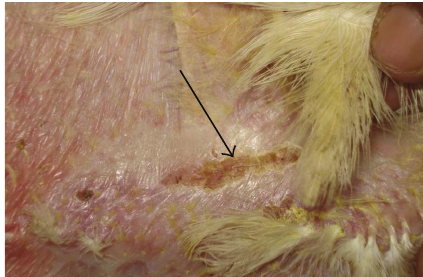
Figure 3: DTH reaction of skin (control): increased thickness and scab formation.